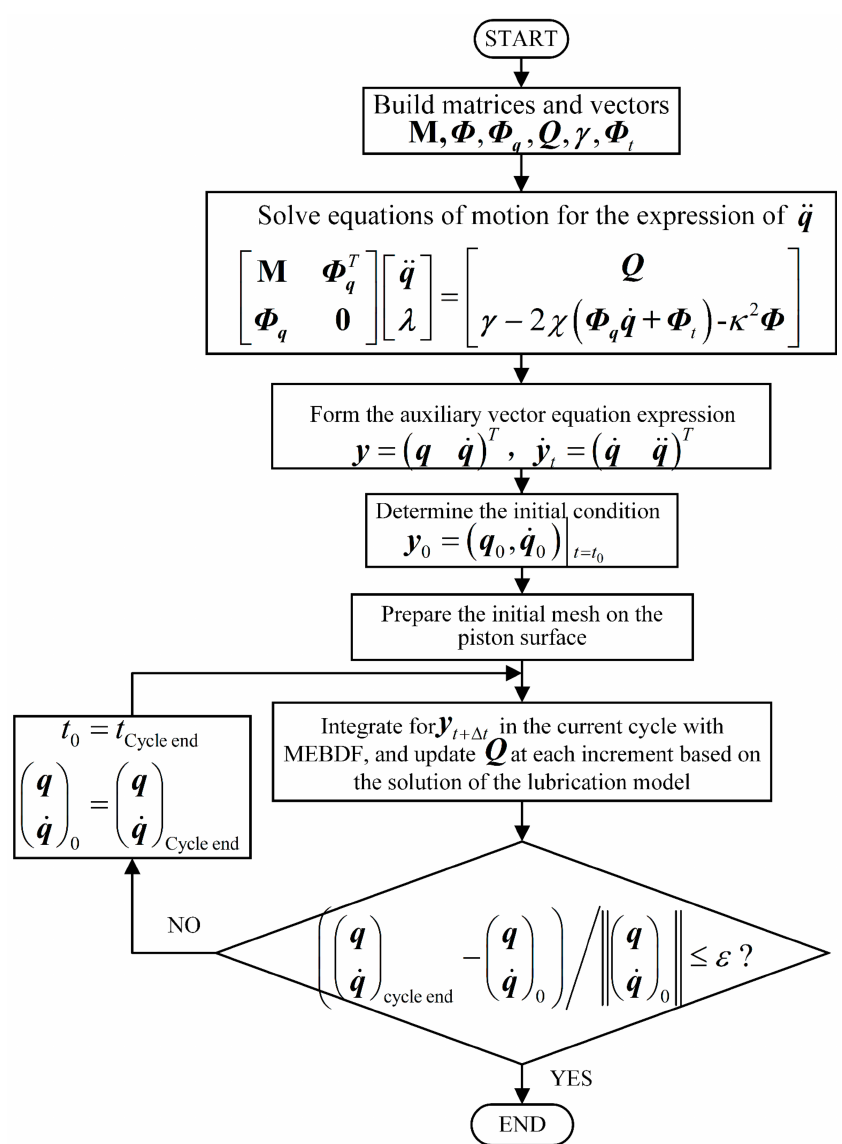
Figure 4. Flowchart of the computational procedure for the analysis of the